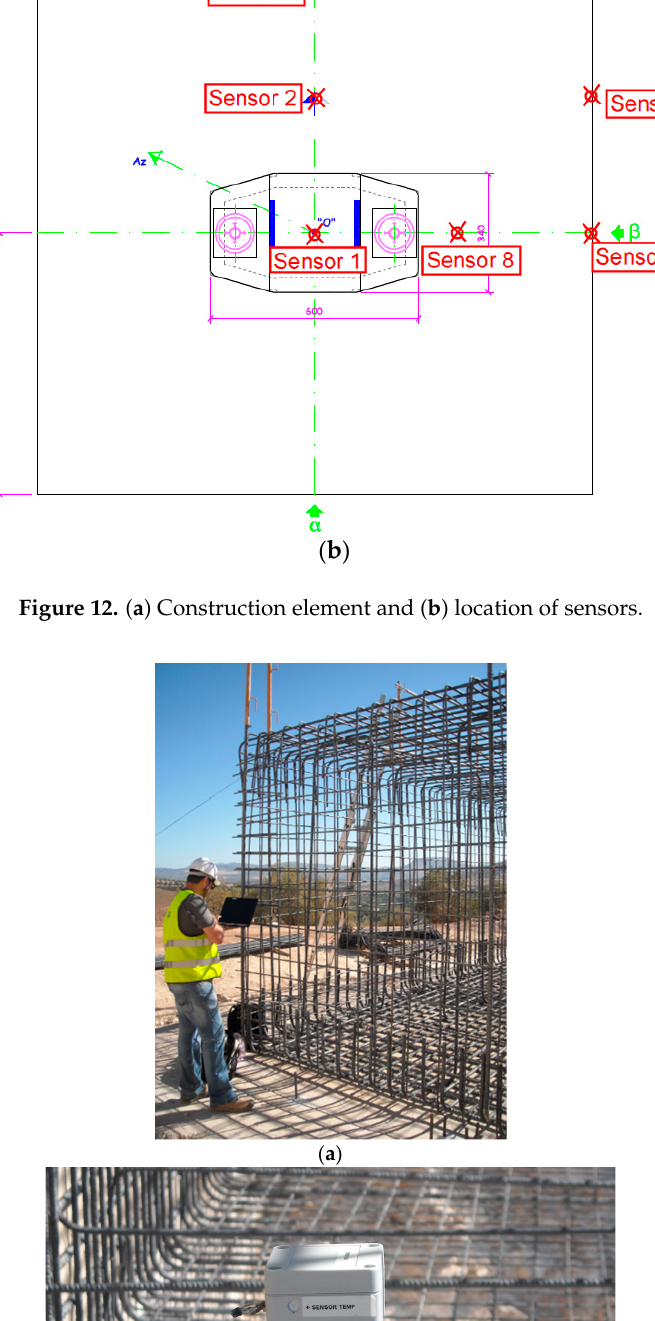
Figure 13. ( a ) Operator testing a sensor on the steel structure; ( b ) Detail of the mote tied to a steel bar.